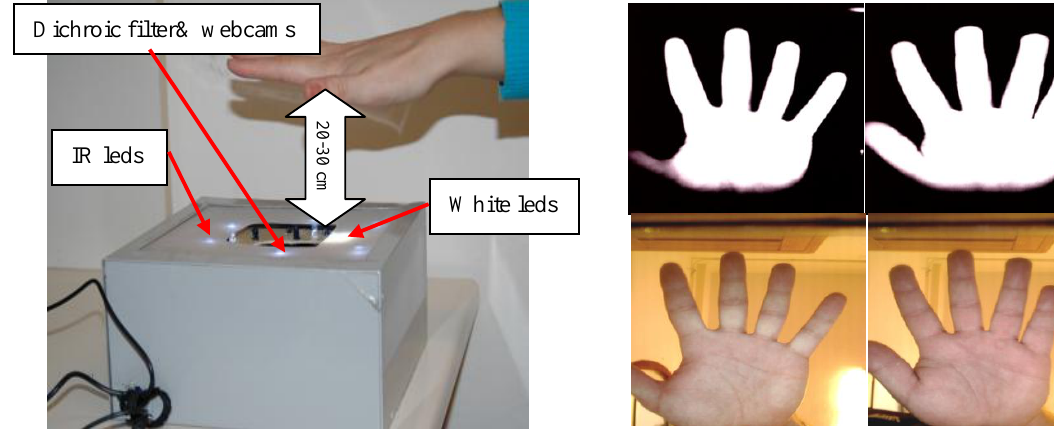
Figure 7. Contactless acquisition system at a medium distance (figure on the left) and acquired IR and visible hand images from two different users (4 figures on the right in upper level IR images; in down level visible